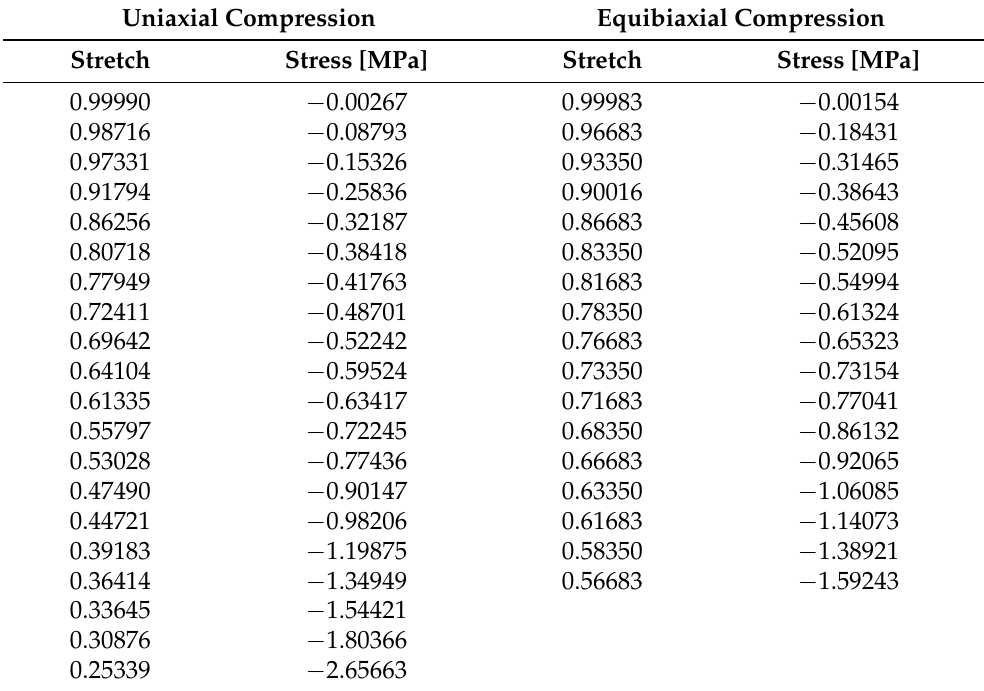
Table 1. Values of experimental tests of uniaxial and equibiaxial